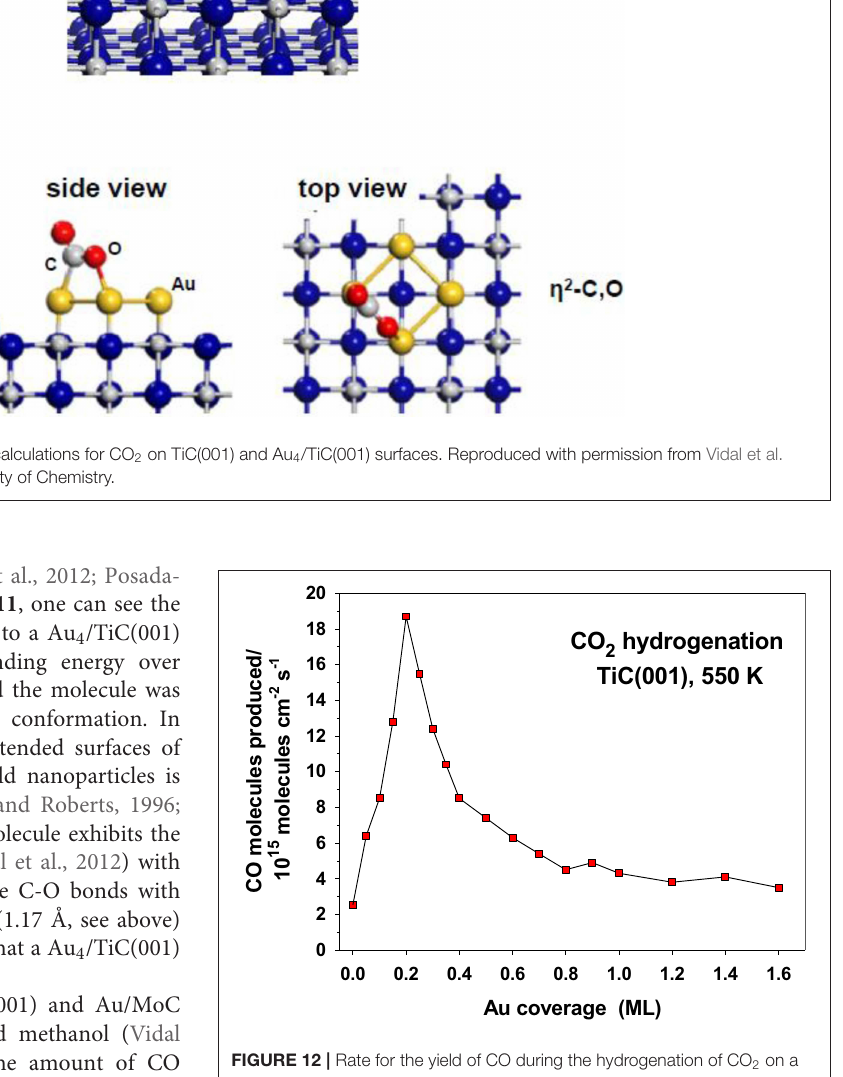
Table 1 . In the case of methanol synthesis, the apparent activation energy drops from a value of 25 Kcal/mol on Cu(111) to